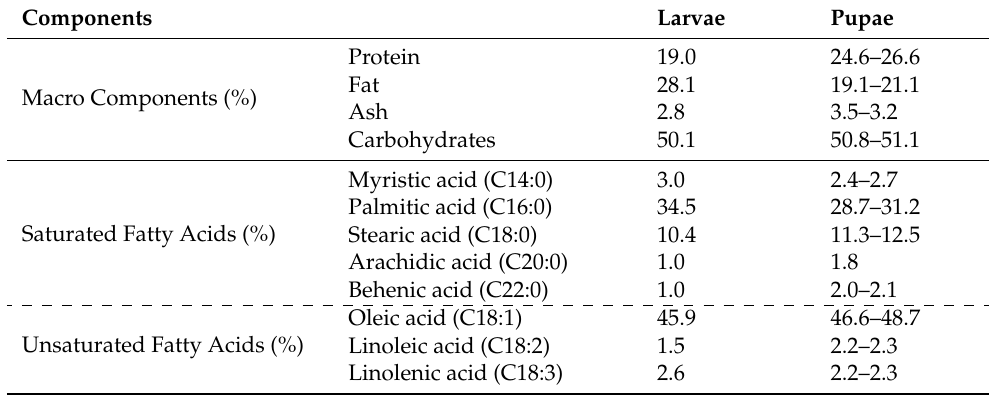
Table 3. Nutritional composition of larvae and pupae of Apis mellifera